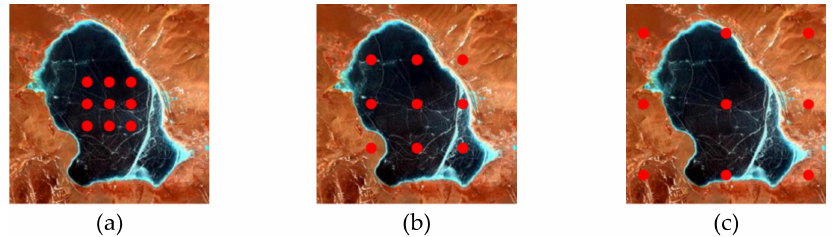
Figure 1. Dilated convolution with different dilated rate r . ( a – c ) are the dilated rates of 0, 1, and 2,